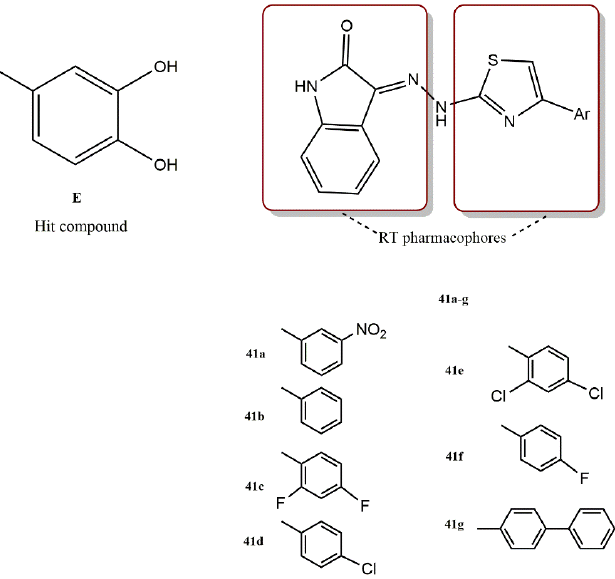
Figure 29. Dual RT pharmacophores of new active synthesized compounds 41a-g .